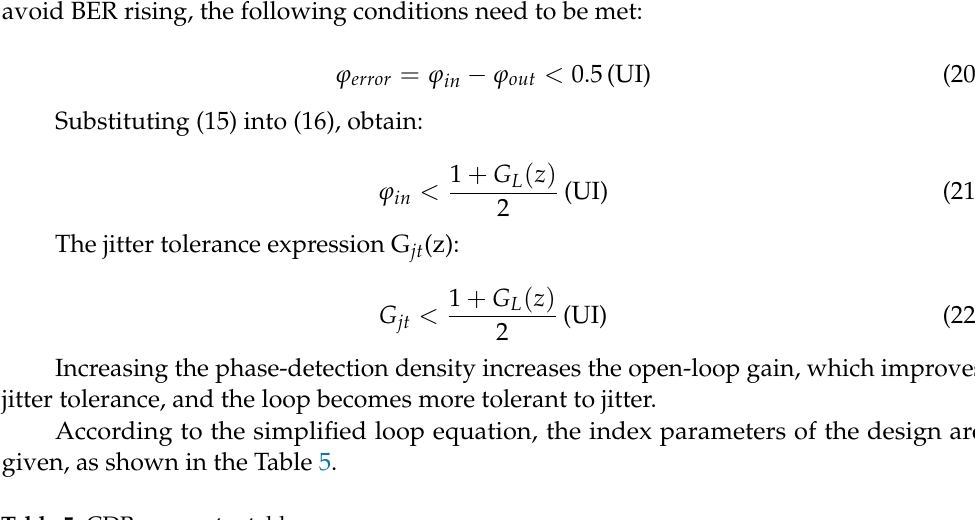
Table 5. CDR parameter